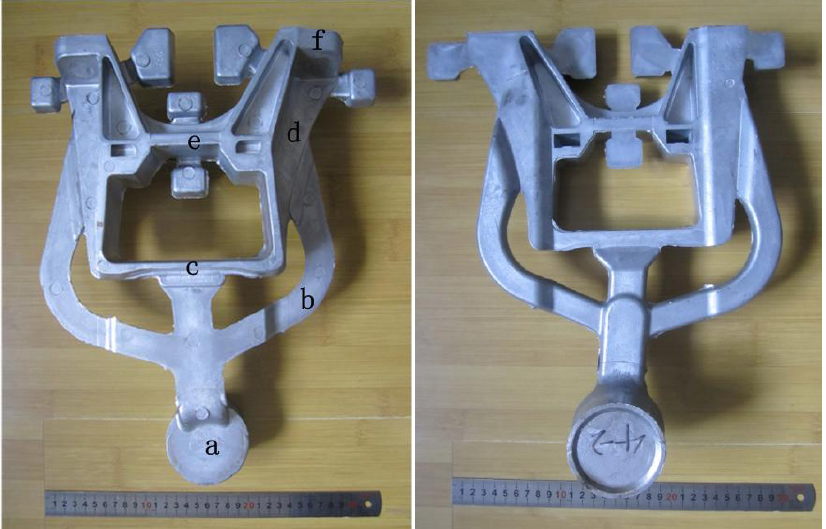
Figure 15. R-HPDC automobile shock absorber